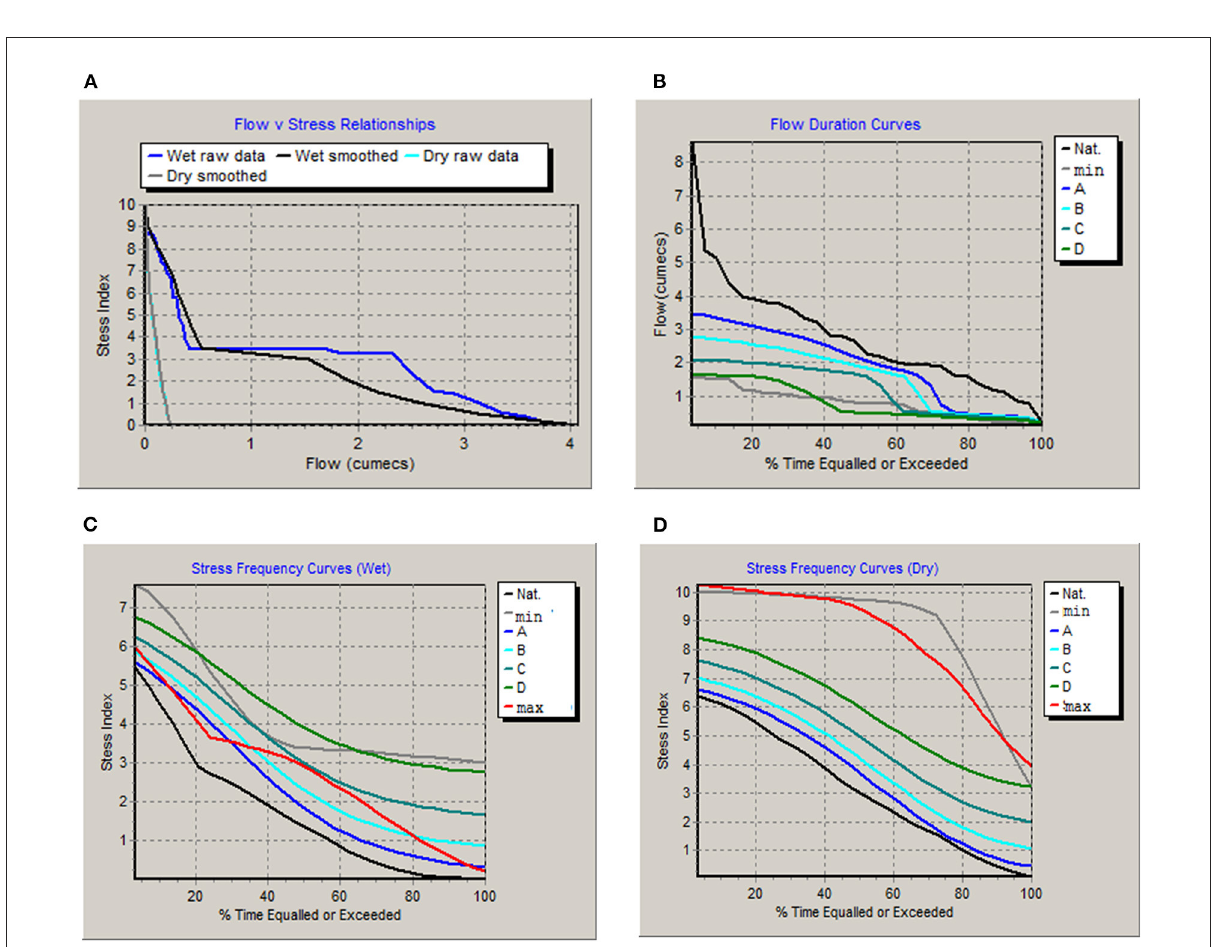
FIGURE5 Outputs of the ecology sub-model with RCP 2.6 minimum and maximum ensembles for upper Ecological Reserve site 6 (Ecological Category B/C) (A) flow vs. stress relationships and (B) flow duration curves for natural, minimum ensemble and the four Ecological Categories (C) stress frequency curves for wet and (D) dry